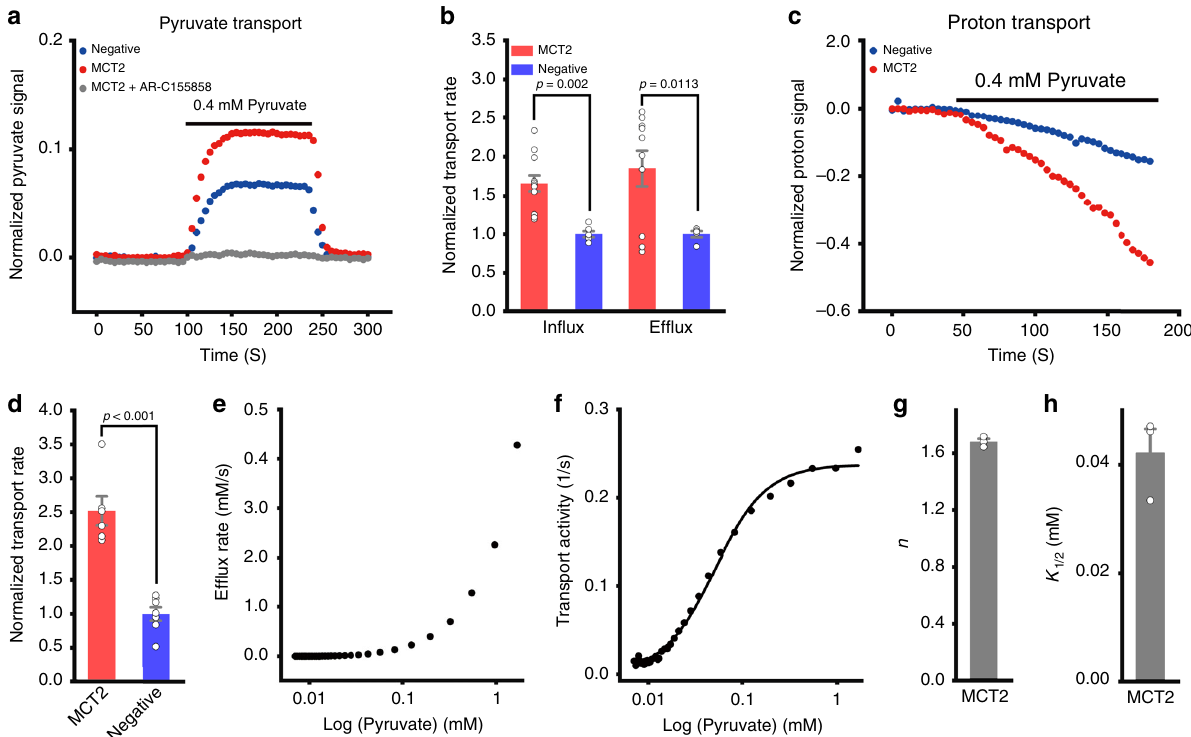
Fig. 1 MCT2 transports pyruvate cooperatively. a – d Assessment of pyruvate (pyronic 12 ) and proton (BCECF-AM 14 ) fl ux in HEK293T cells expressing either MCT2 (red) MCT2 upon pre-incubation with AR-C155858 13 (gray), or empty vector control (blue). a Representative traces and b, bar plots depicting normalized rates of pyruvate in fl ux and ef fl ux (for pyruvate in fl ux, WT MCT2, n = 12; Negative, n = 6; for pyruvate ef fl ux, WT MCT2, n = 10; Negative, n = 5). c Corresponding representative traces and d bar plots depicting normalized rates of proton in fl ux (WT MCT2, n = 6; Negative, n = 7). e , f Plots of e , pyruvate ef fl ux rate or f transport activity measured at an extracellular pyruvate concentration of 0 mM as a function of intracellular pyruvate concentration for MCT2 at an extracellular pH 7.4. The smooth lines are fi tted with the Hill equation, activity = activity max /(1 + (K 1/2 /[pyruvate]) n ), where n is the Hill coef fi cient and K1/2 is the [pyruvate] required for activity to reach half of maximum. g , h Quanti fi cation of Hill coef fi cient ( n value) and K1/2 of WT MCT2. Bar plots of g depicting Hill coef fi cient (n value) ( n = 3). Bar plots of h depicting K 1/2 ( n = 3). For WT MCT2, n = 1.6 and K1/2 = 42 μ M. Bar plots data were presented as mean±SEM. One-tailed t